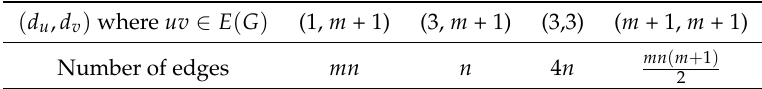
Table 6. The edge partition of the graph G